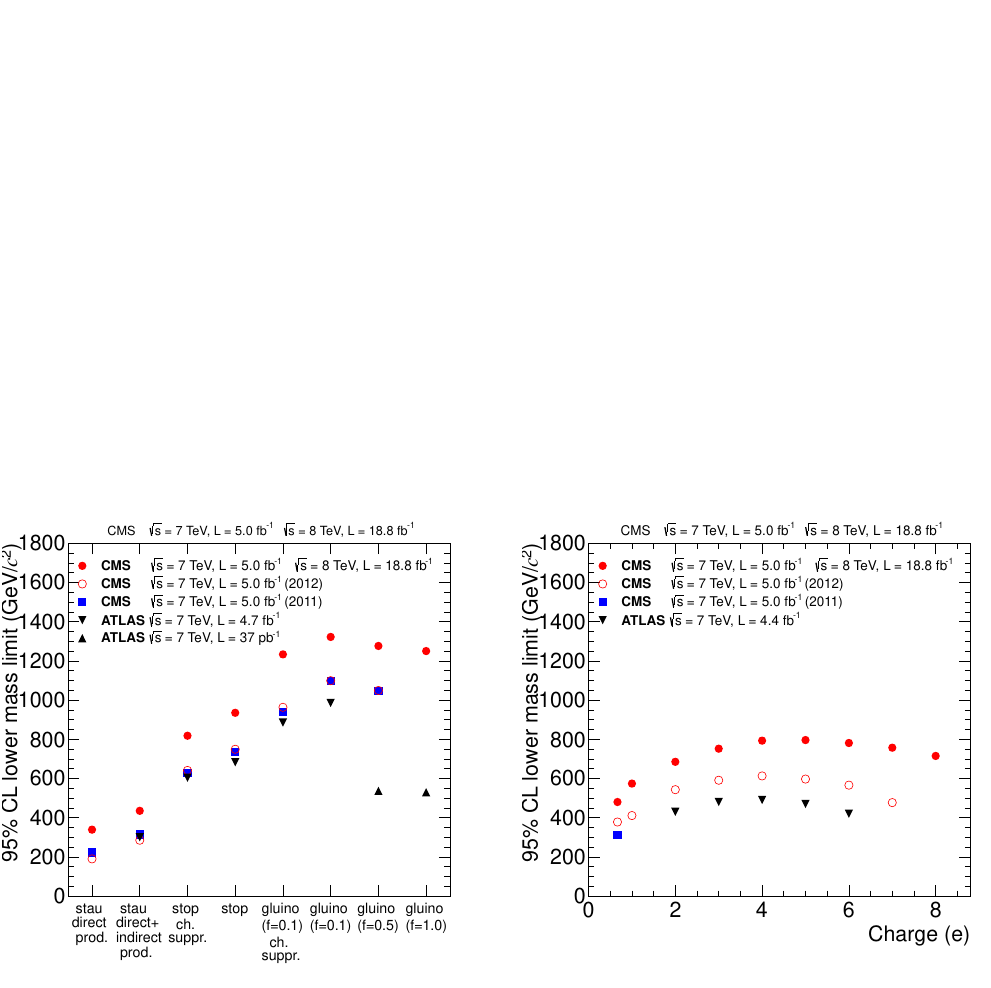
Figure 11 . Lower mass limits at 95% C.L. for various models compared with previously published results [19–26]. The model type is given on the x-axis (left). Mass limits are shown for Drell-Yan like production of fractionally, singly, and multiply charged particles (right). These particles were assumed to be neutral under SU(3) and SU(2) C L